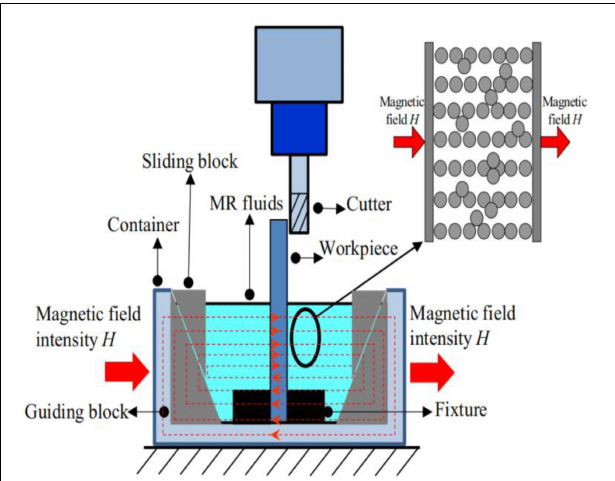
FIGURE 2 | The schematic diagram of flexible fixture system (Ma et al., 2016).